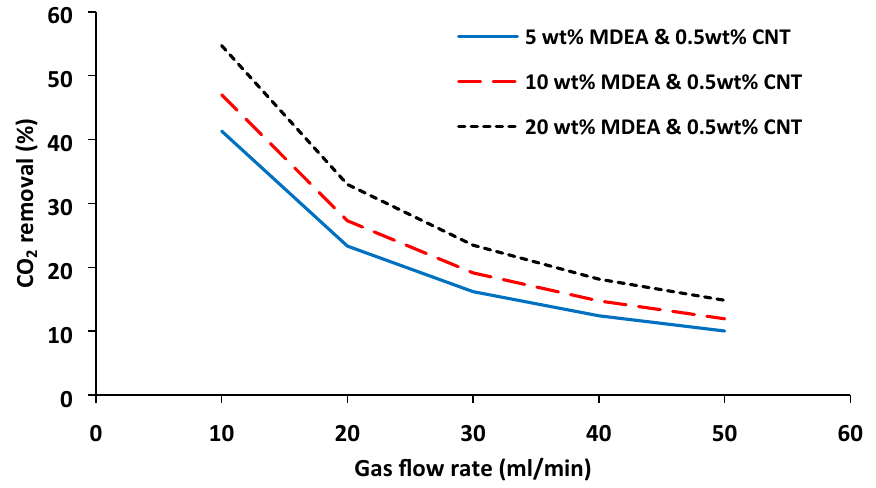
Figure 5. CO 2 removal % as a function of gas mixture flow rate and MDEA concentration with 0.5 wt% CNT NPs at 10 ml/min MDEA-based